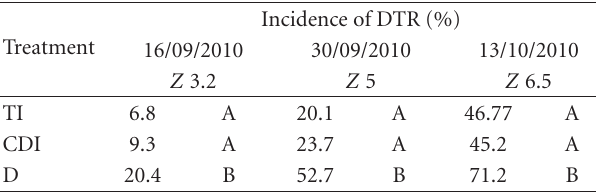
Figure 2: Average, minimum, and maximum air temperature ( ◦ C) and precipitation (mm) during the 2010 growing season.